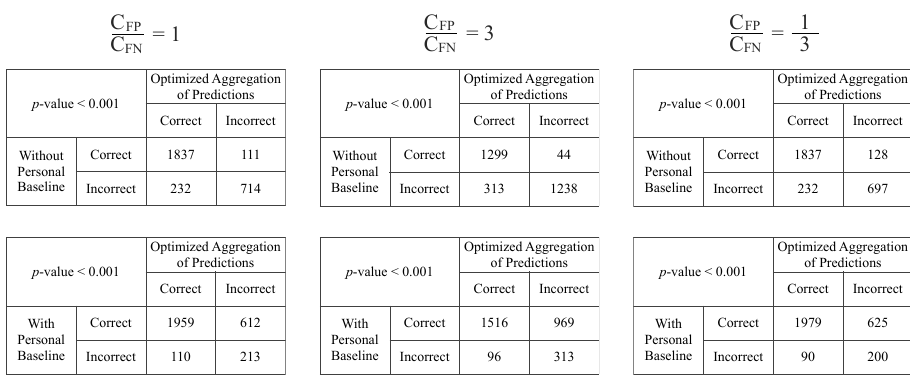
Figure 7. The contingency tables and the p -values for the McNemar’s tests. The C FP ratio may vary across different healthcare sites or organizations due to the C FN different tiers of care, varying implementation of the best practices of care, or even tem- porally varying availability of healthcare providers or other resources. With the proposed framework, which selects the optimal decision threshold by minimizing the expected costs of misclassifications, the same trained model can be tuned to optimize the operational